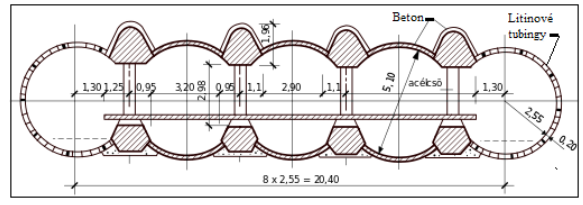
Figure 7. Kossuth Lajos Square five-vault station on Line M2 [2]